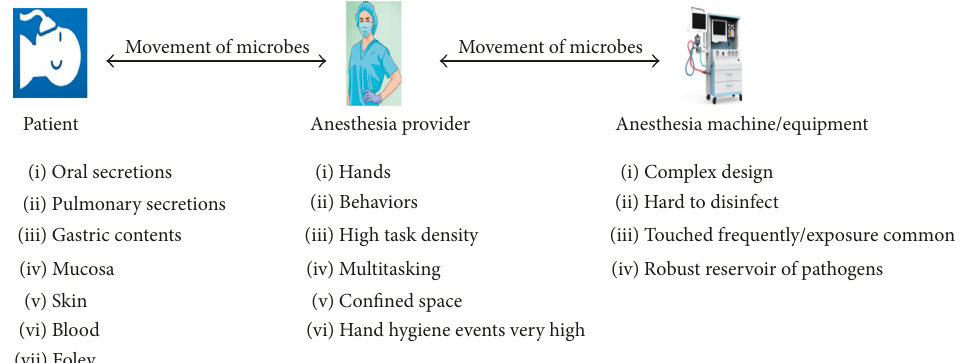
Figure 4: Horizontal transfer of microbes in the anesthesia work